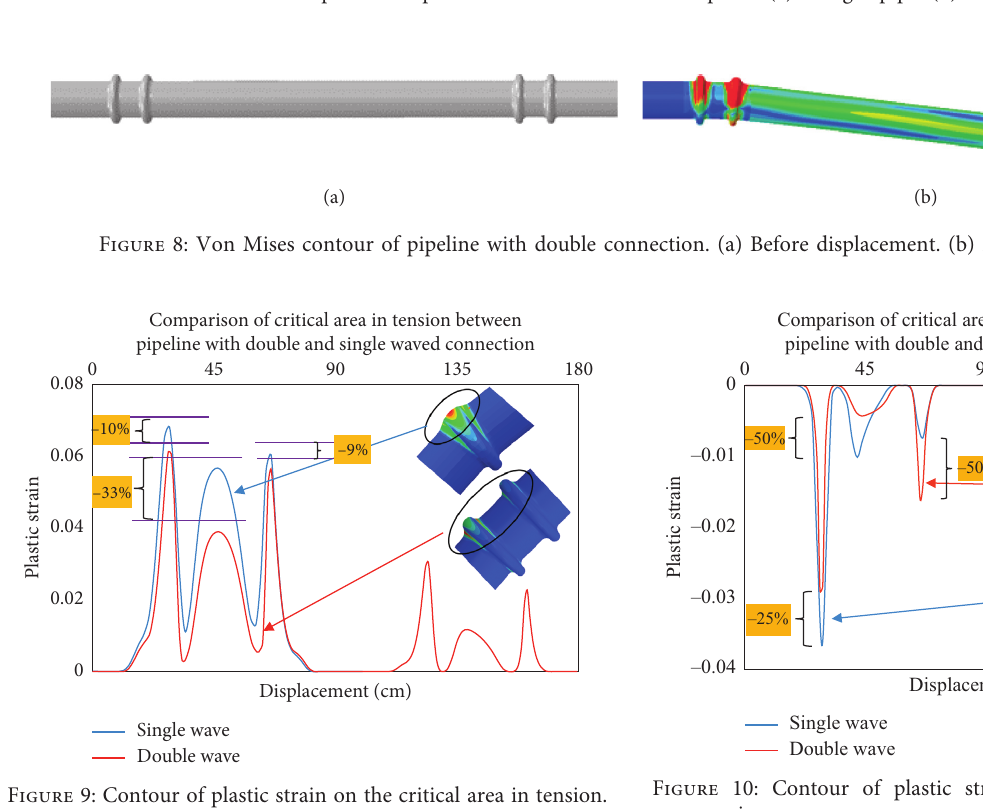
Figure 7: Comparison of plastic strain results in critical point. (a) Straight pipe. (b) Waved pipe.